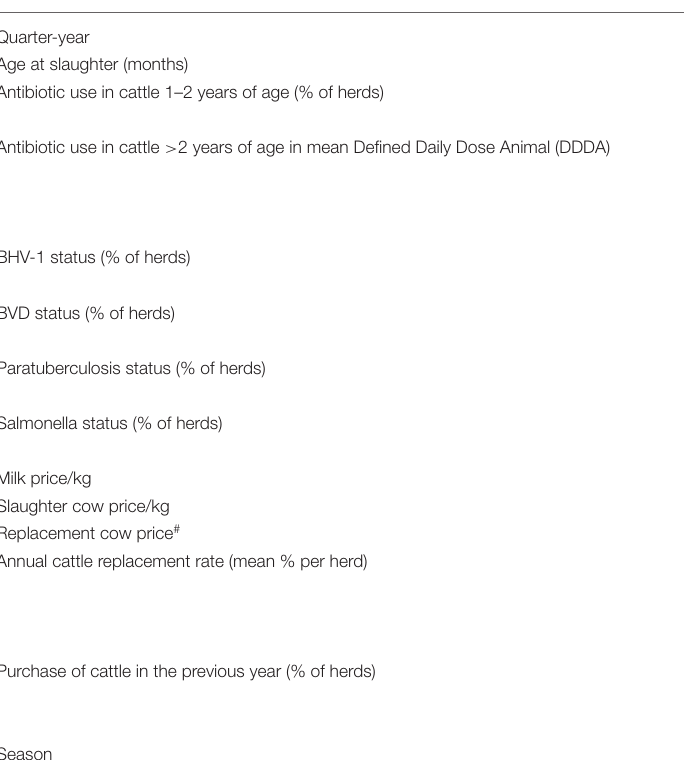
TABLE 1 | Characteristics of dairy herds in the slaughterhouse dataset that were used as independent variables in the multivariable analyses to quantify associations between herd characteristics and the herd-level frequency of AM- and PM-findings amongst slaughtered cattle in one Dutch slaughterhouse ( N = 10,406 dairy herds).